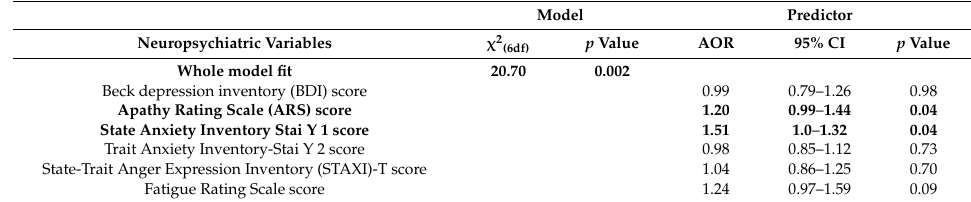
Table 3. Results from the multivariable logistic regression on group membership (WMH + WMH − ) and significant neuropsychiatric